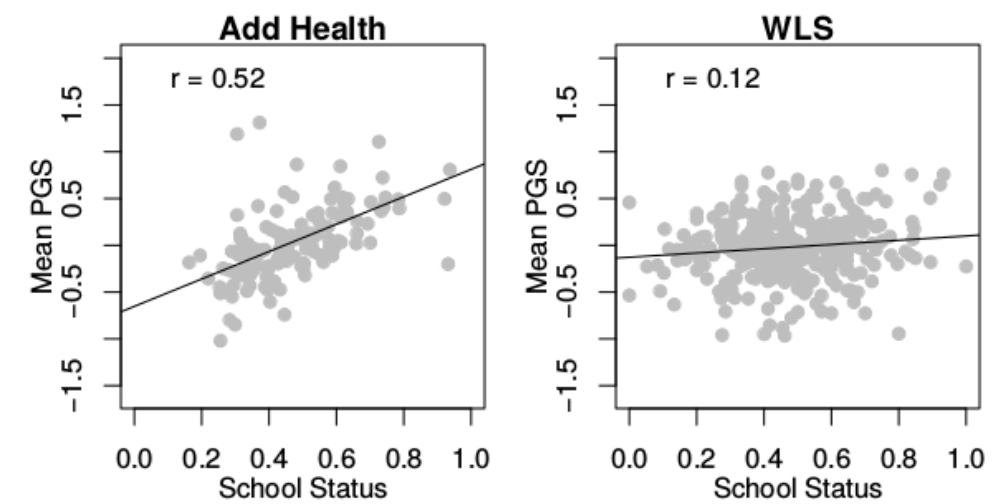
Figure 1: Mean PGS for the respondent as a function of school status (percent of parents with a high school diploma) in each data set. PGS, polygenic score; WLS, Wisconsin Longitudinal